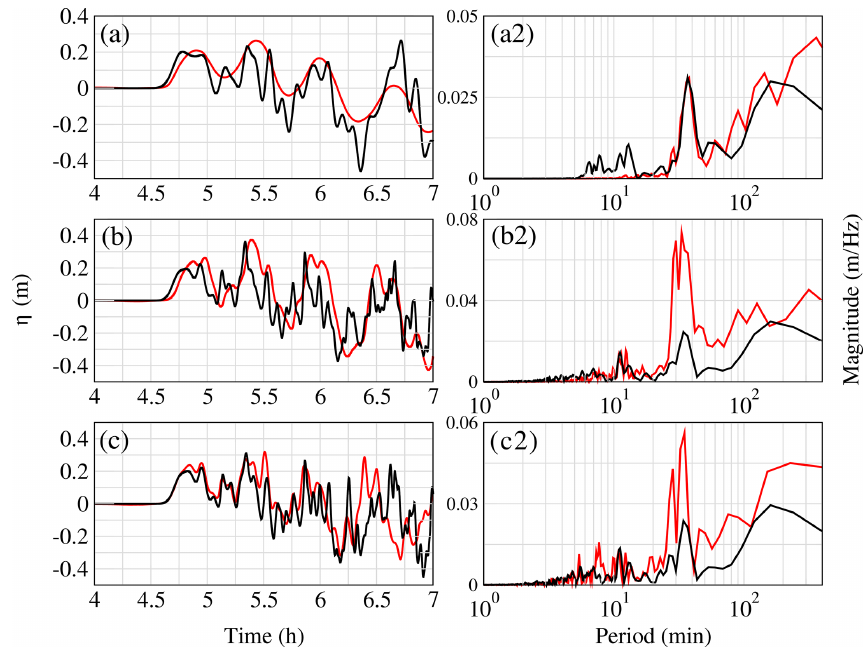
Figure 19. Comparison of the surface elevation (m) and the associated periods computed by a Fourier transformation (a2 , b2 and c2 ) at Gauge 6 between Calypso (in black) and FUNWAVE-TVD (in red) for the 80km 3 scenario at the Gironde estuary for three resolutions: 2.7km (a) , 450m (b) and 110m (c) for FUNWAVE-TVD and 2km (a) , 500m (b) and 125m (c) for Calypso. The time takes into account the first 20min of the slide and tsunami